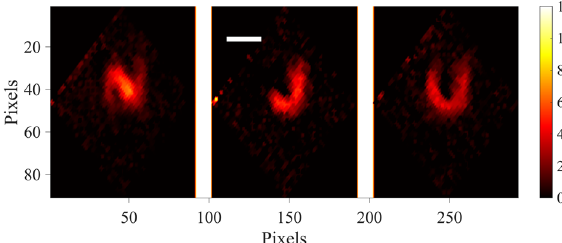
Fig. 3 Interaction-free quantum imaging result of the ‘ NJU ’ characters with undetected photons. In the presence of the plate in arm ③ of the interaction-free measurement module, two images are obtained with ICCD at phase setting ( θ ¼ π ; ϕ ¼ 0 ) and ( θ ¼ 0 ; ϕ ¼ π ) (see the Supplementary Fig. 4a and 4b). The difference between these two images is shown above. The signal photon inside the three characters has higher visibility than in outside regions. The three characters ‘ N ’ , ‘ J ’ and ‘ U ’ are measured independently. The length of the scale bar (white colour) in the fi gure is 200 μ m .